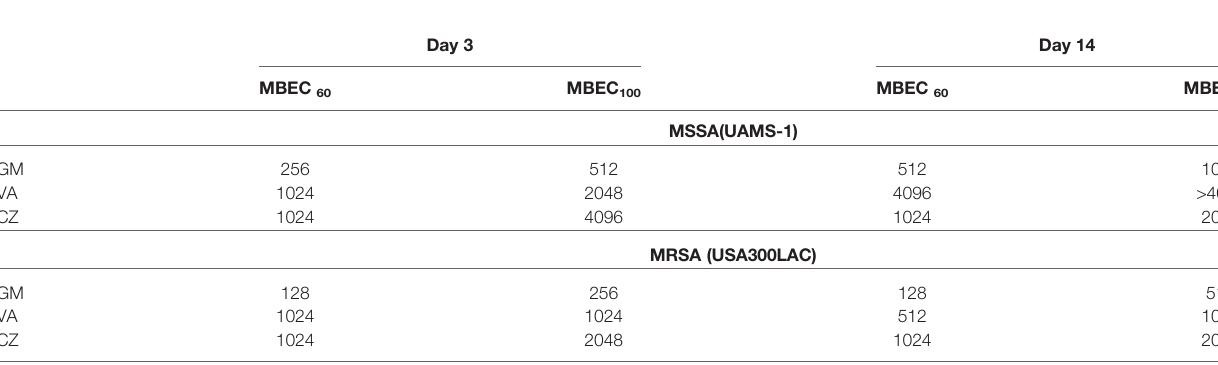
TABLE 2 | MBEC on bacteria on in vivo bio fi lm formed on a screw ( in vivo